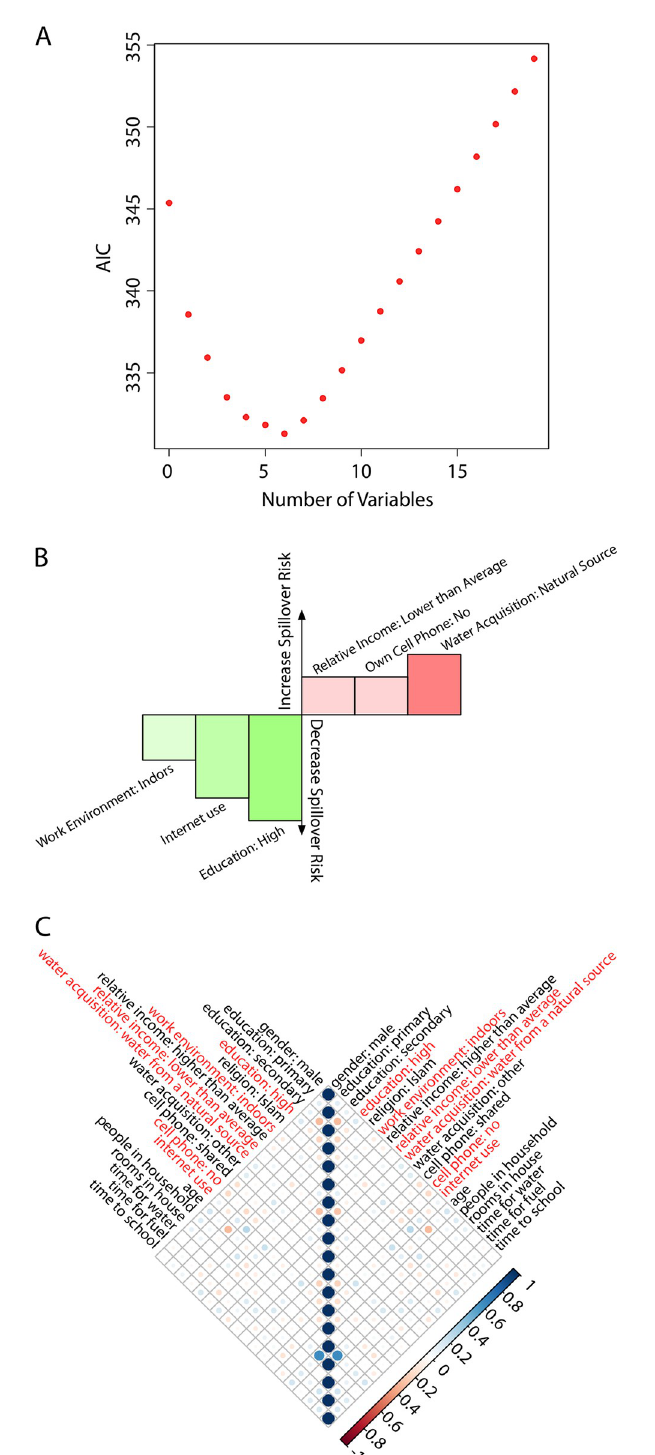
Fig 4. A: AIC values as a function of the number of variables (features) . Either starting from a null model and increasing the number of features (forward stepwise logistic regression) or from a complete model and decreasing the number of features (backward stepwise logistic regression), we consistently found that a model with six variables shows a global minimum for AIC (minimum prediction error). B: Graphical representation of the logistic regression coefficients . Magnitude of the β coefficients (normalized to the maximum) and their sign (positive/negative: i